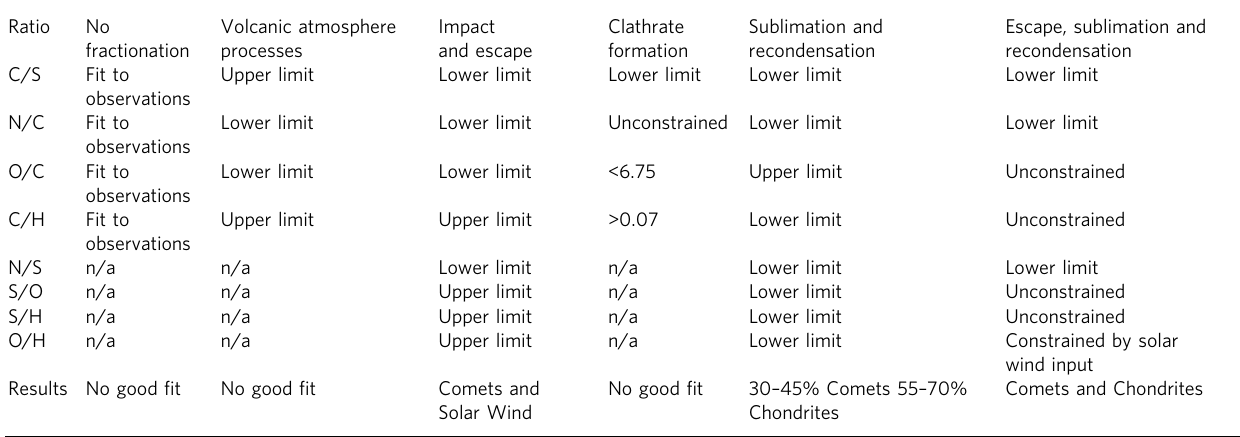
In the case of no fractionation, the model was determined to be a good fi t if the modeled ratios were within errors of the LCROSS observations and the uncertainties of the sources. The N/S, S/O, S/H, and O/H constraints for impact and escape were not used in the impact and escape modeling, but were used when determining constraints for the fi nal column that combined impact and escape with sublimation and